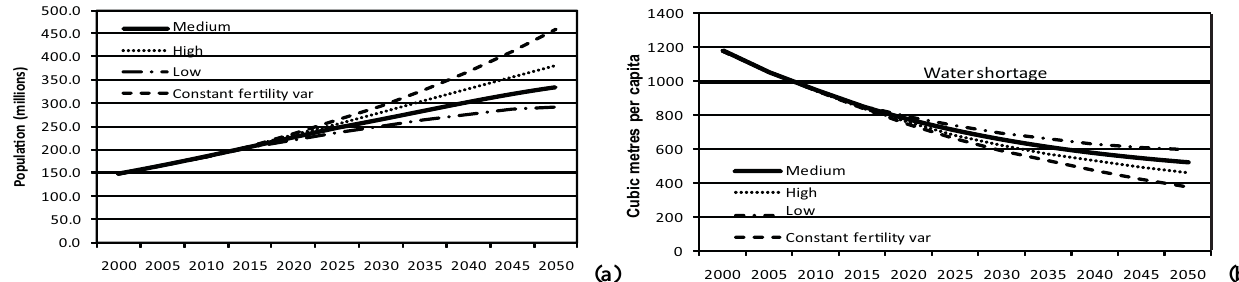
Fig. 3. (a) Projected population growth showing four variants based on UN (2009) population estimates and (b) per capita water availability and available runoff of 175 billion cubic